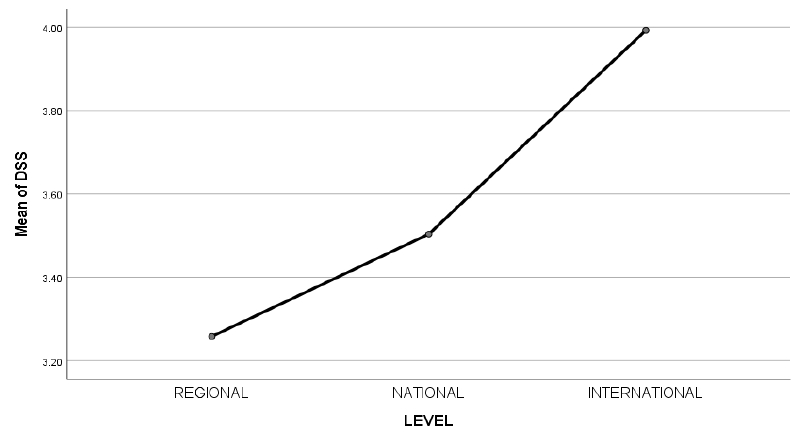
Figure 1. Mean of DSS in relation to the level of professionalism.